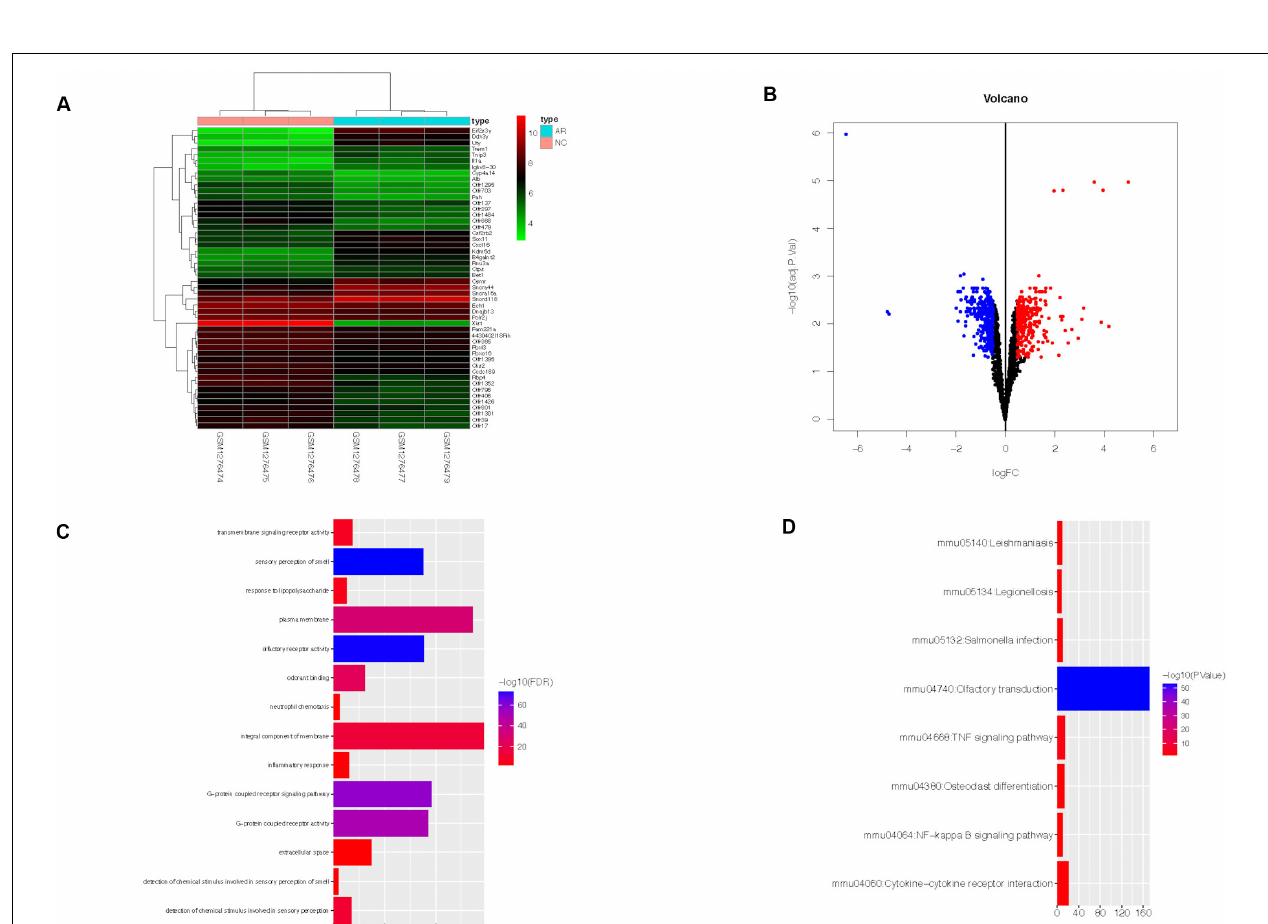
FIGURE 2 | Heatmap, volcano plot, GO, and KEGG functional enrichment results of 634 DEGs in AR. The x -axis represents gene count and the y -axis represents GO or KEGG terms. (A) The top 50 DEGs identified by R software. The highly expressed genes of the AR group compared with the control group were represented by the red areas and the lowly expressed genes were represented by the green areas. (B) Red dots represent the up-regulated genes and blue dots represent the down-regulated genes of the AR group compared with the control group. (C) GO functional enrichment result of DEGs. (D) KEGG functional enrichment result of DEGs. DEGs, differentially expressed genes; AR, allergic rhinitis. GO, Gene Ontology; KEGG, Kyoto Encyclopedia of Genes and Genomes.